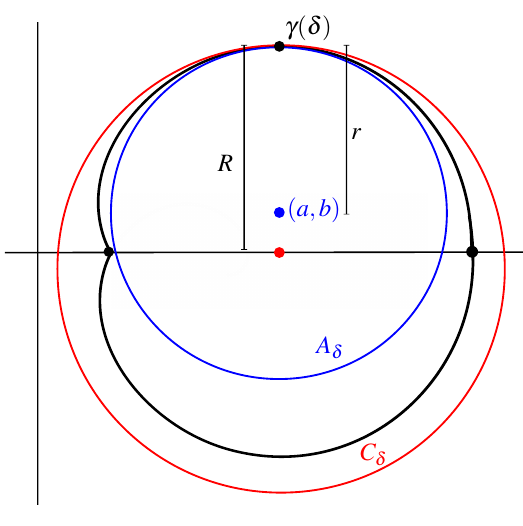
Figure 7: The canonical circle C δ and the osculating circle A δ